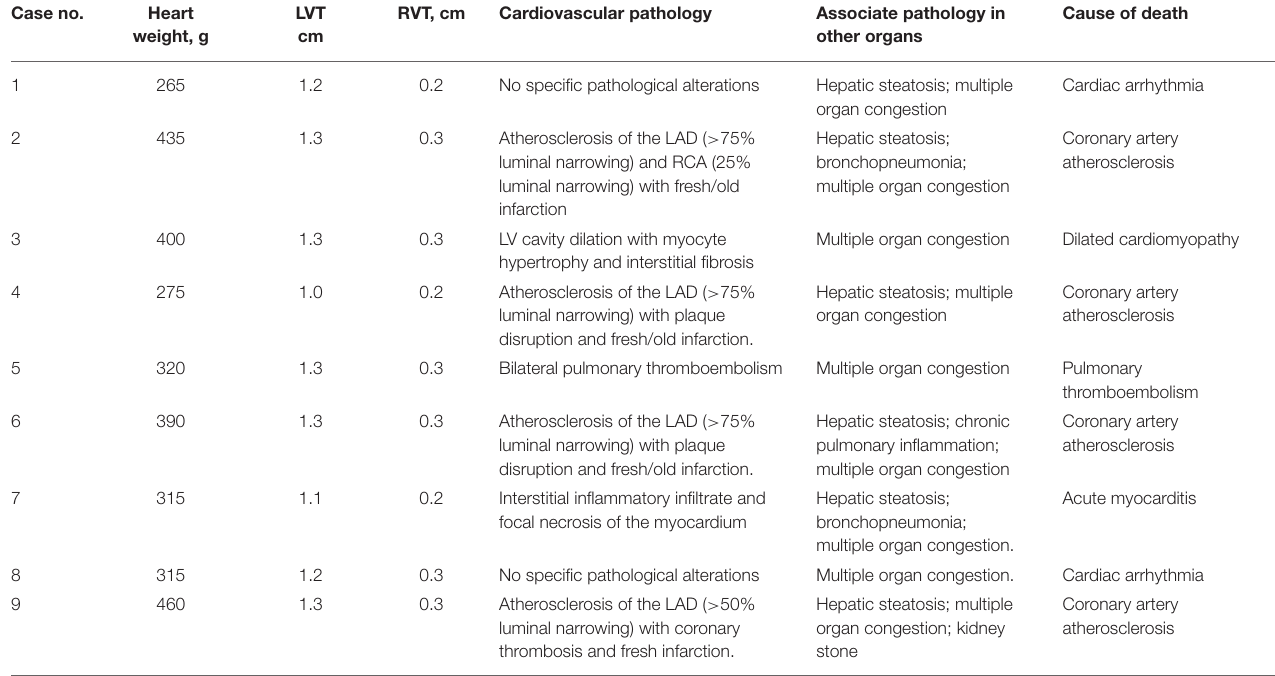
TABLE 2 | Autopsy findings of the deceased patients ( n = 9). Case